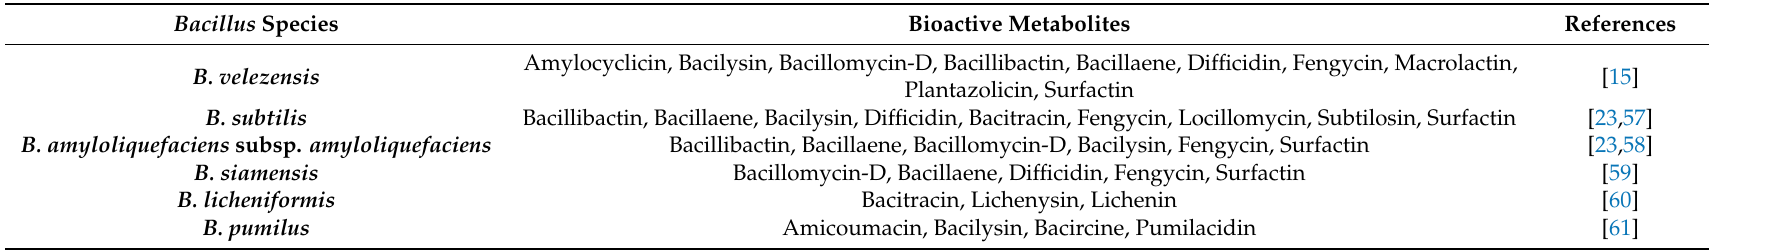
Table 2. List of various bioactive metabolites synthesized by B. velezensis and the closely related